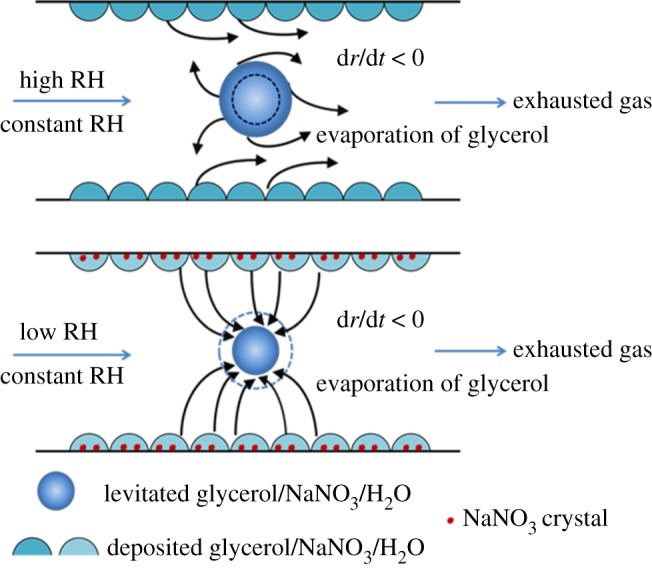
The schematic diagram of the evaporation of glycerol in the glycerol/NaNO3/H2O droplets.